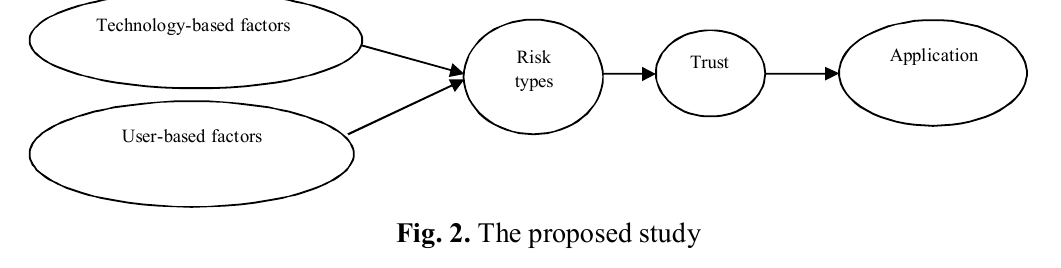
Fig. 2. The proposed